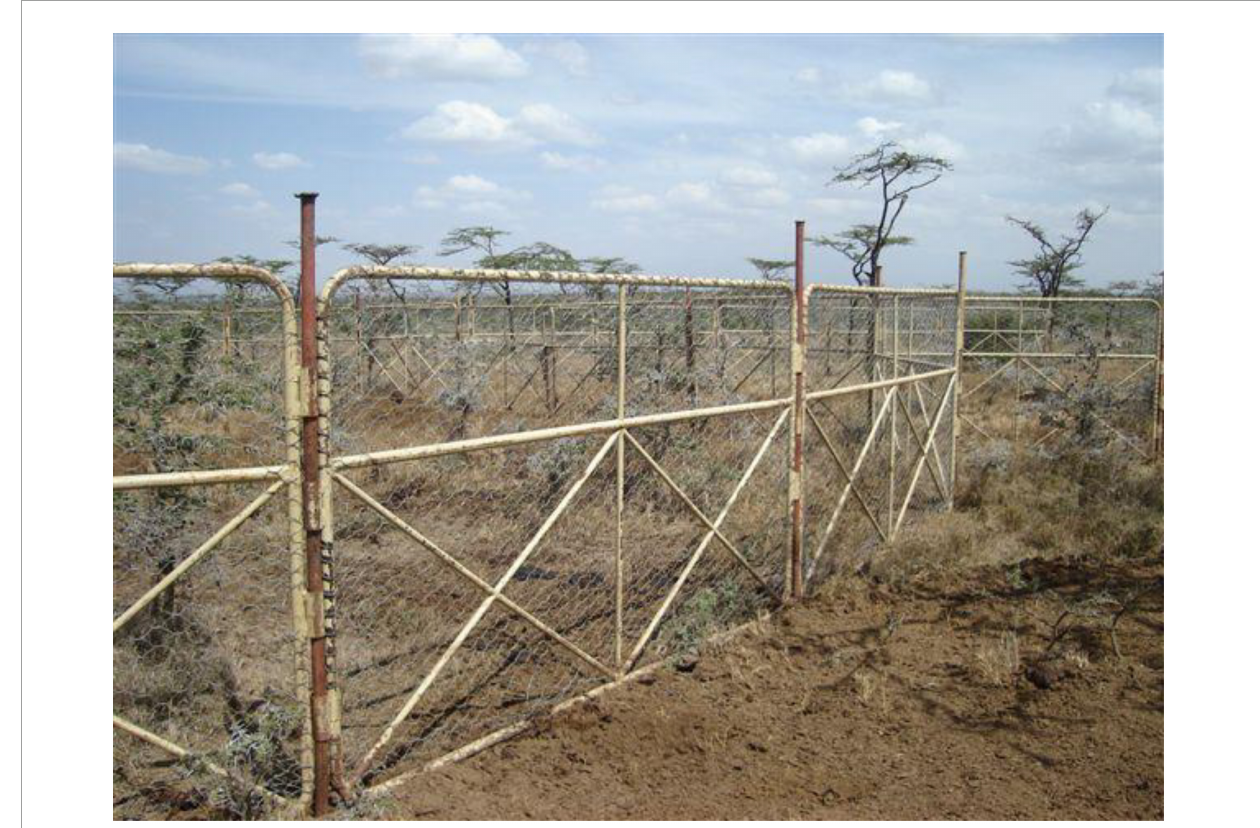
FIGURE6 “Lion-proof” mobile boma developed by a Laikipia rancher, consisting of interlocking panels of steel pipe and chain link fencing which can be disassembled and moved to another location. These are strong enough to resist stampeding cattle panicked by lions and dramatically reduced night time livestock